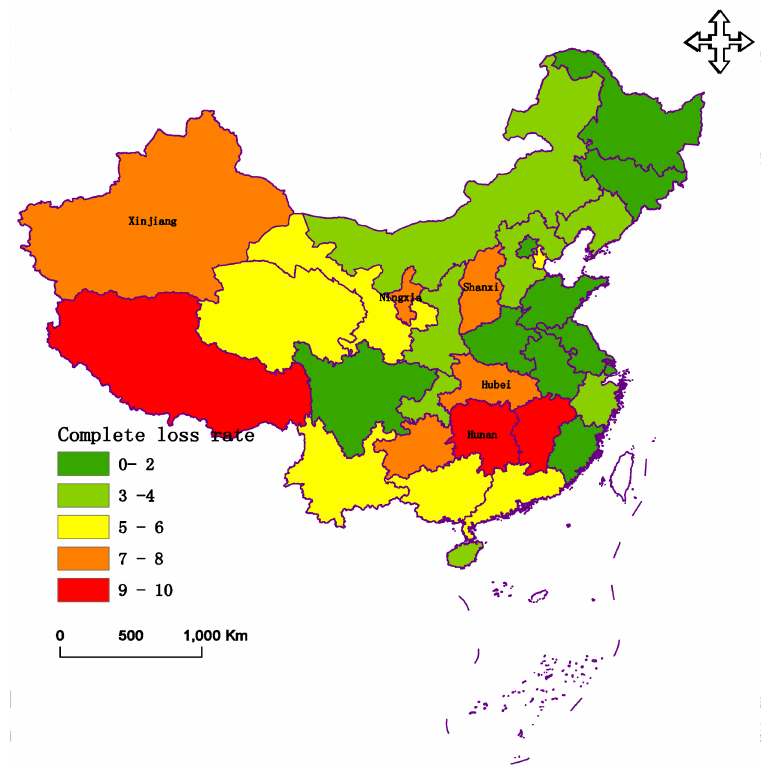
Figure 5. The data of the complete loss rate ( C 3) in 2008.